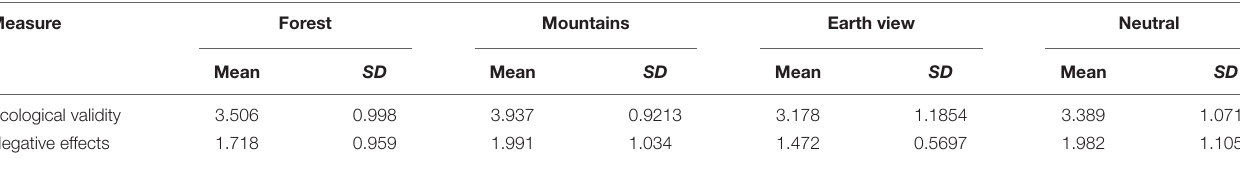
TABLE 4 | Ecological validity and negative effect scores for each condition: Mean and standard deviation for each condition.